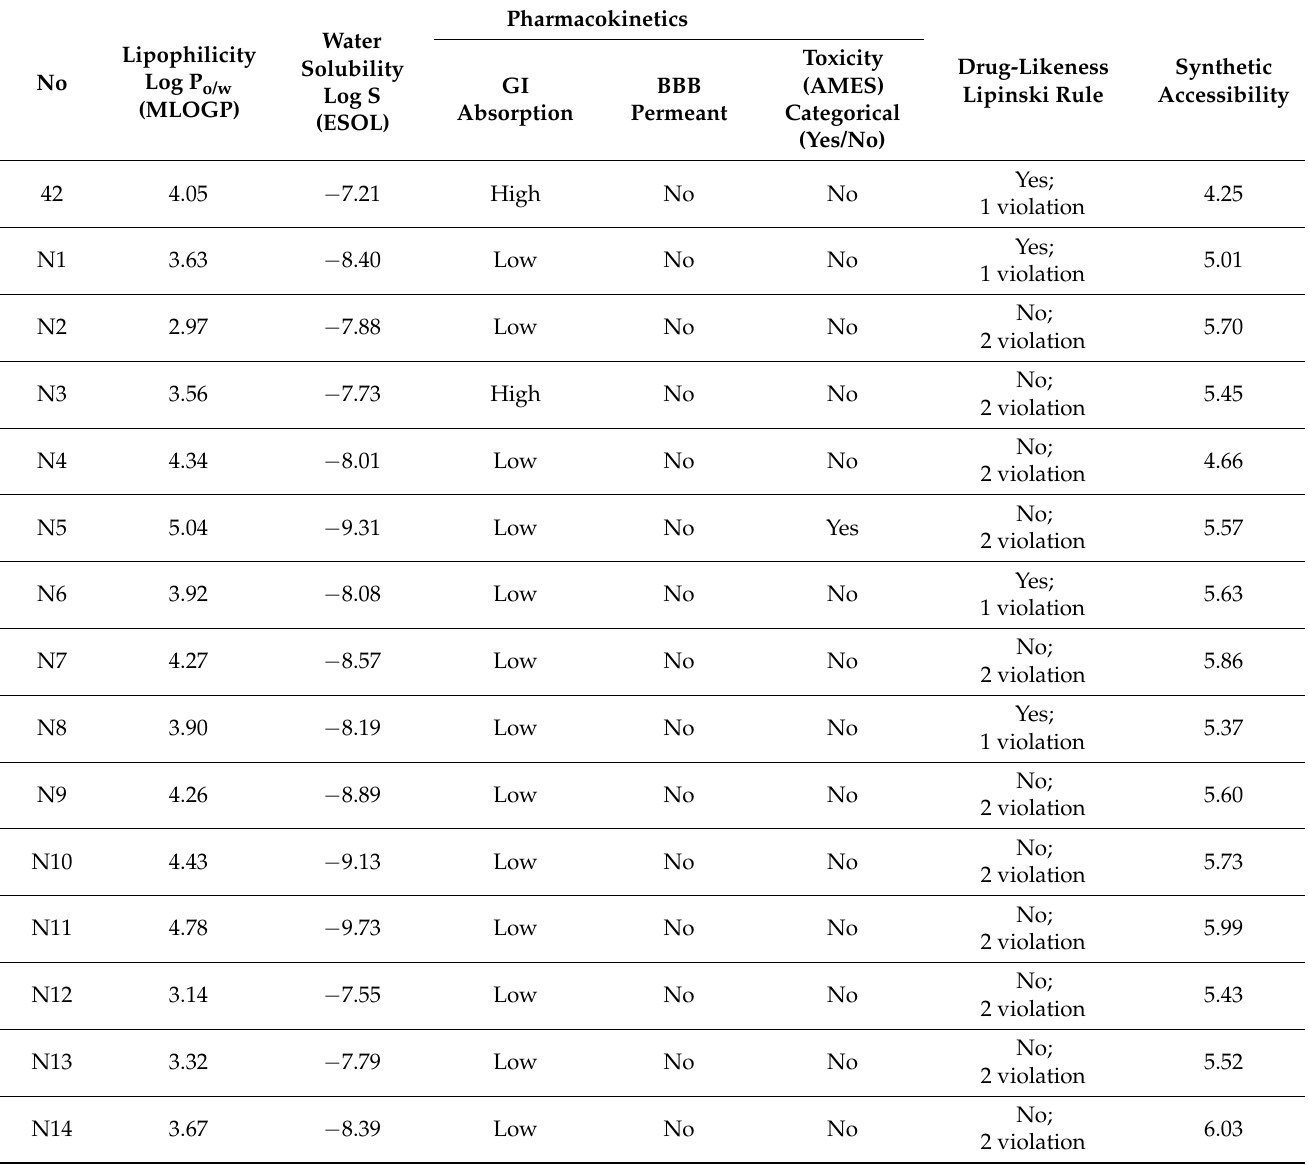
Table 5. The prediction results of ADMET parameters, pharmacokinetic properties, and drug-likeness of the most active compound 42 and the novel designed inhibitors N1 – N14